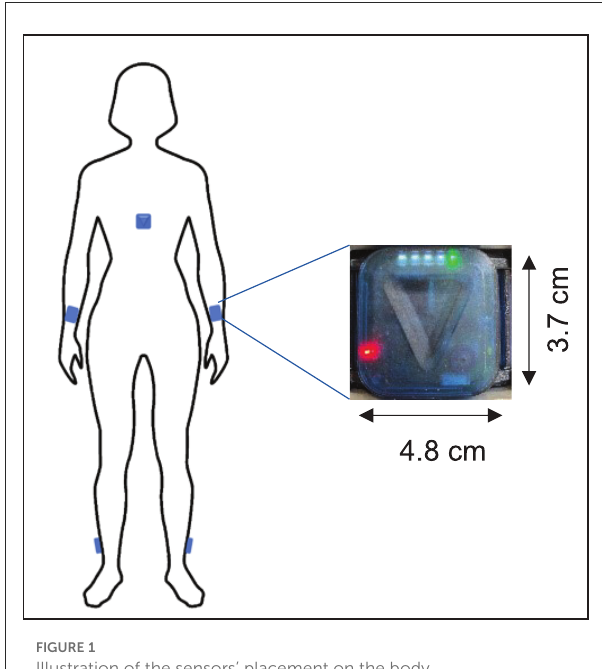
FIGURE1 Illustration of the sensors’ placement on the